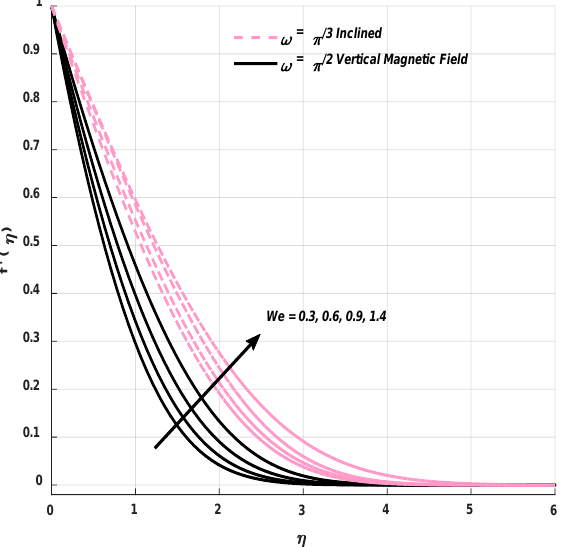
Figure 4. Revealing the performance of We against f (cid:48) ( η ) .